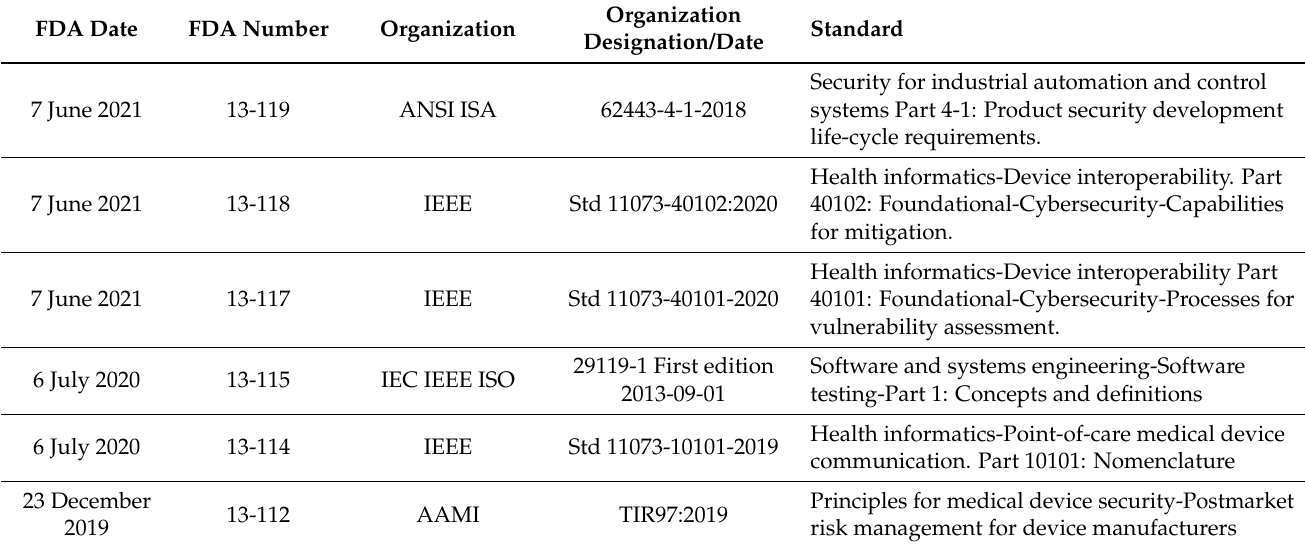
Table 8. U.S. FDA-recognized standards for medical informatics